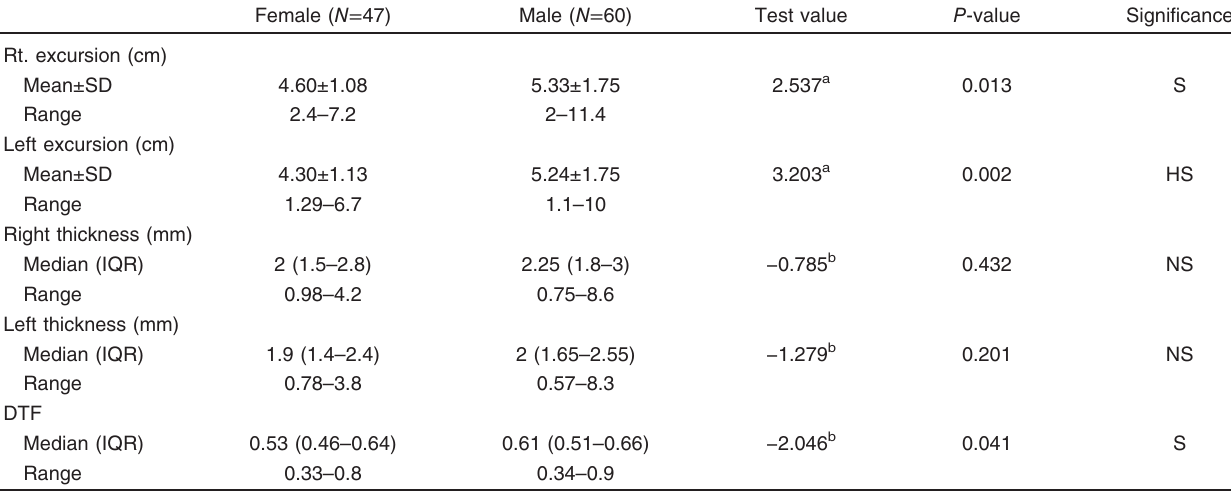
Table 8 Comparison between men and women as regards ultrasonic diaphragmatic indices Female ( N = 47) Male ( N = 60)